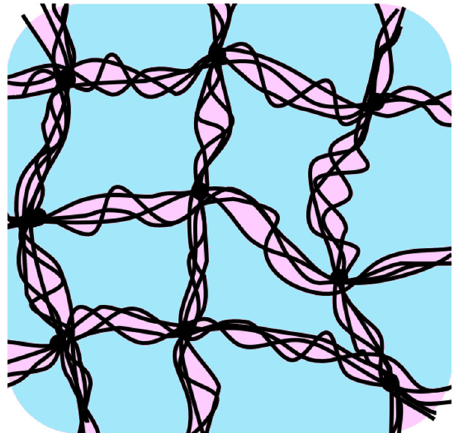
Figure 8. Schematic diagram of the network structure of Sephadex ® G25 gel ( h = 1.00). Two types of molecular assemblies of water separated from each other are shown. Blue: compartmentalized by the network structure made of crosslinked dextran, pink: confined within the narrow spaces formed by the entangled dextran chains.